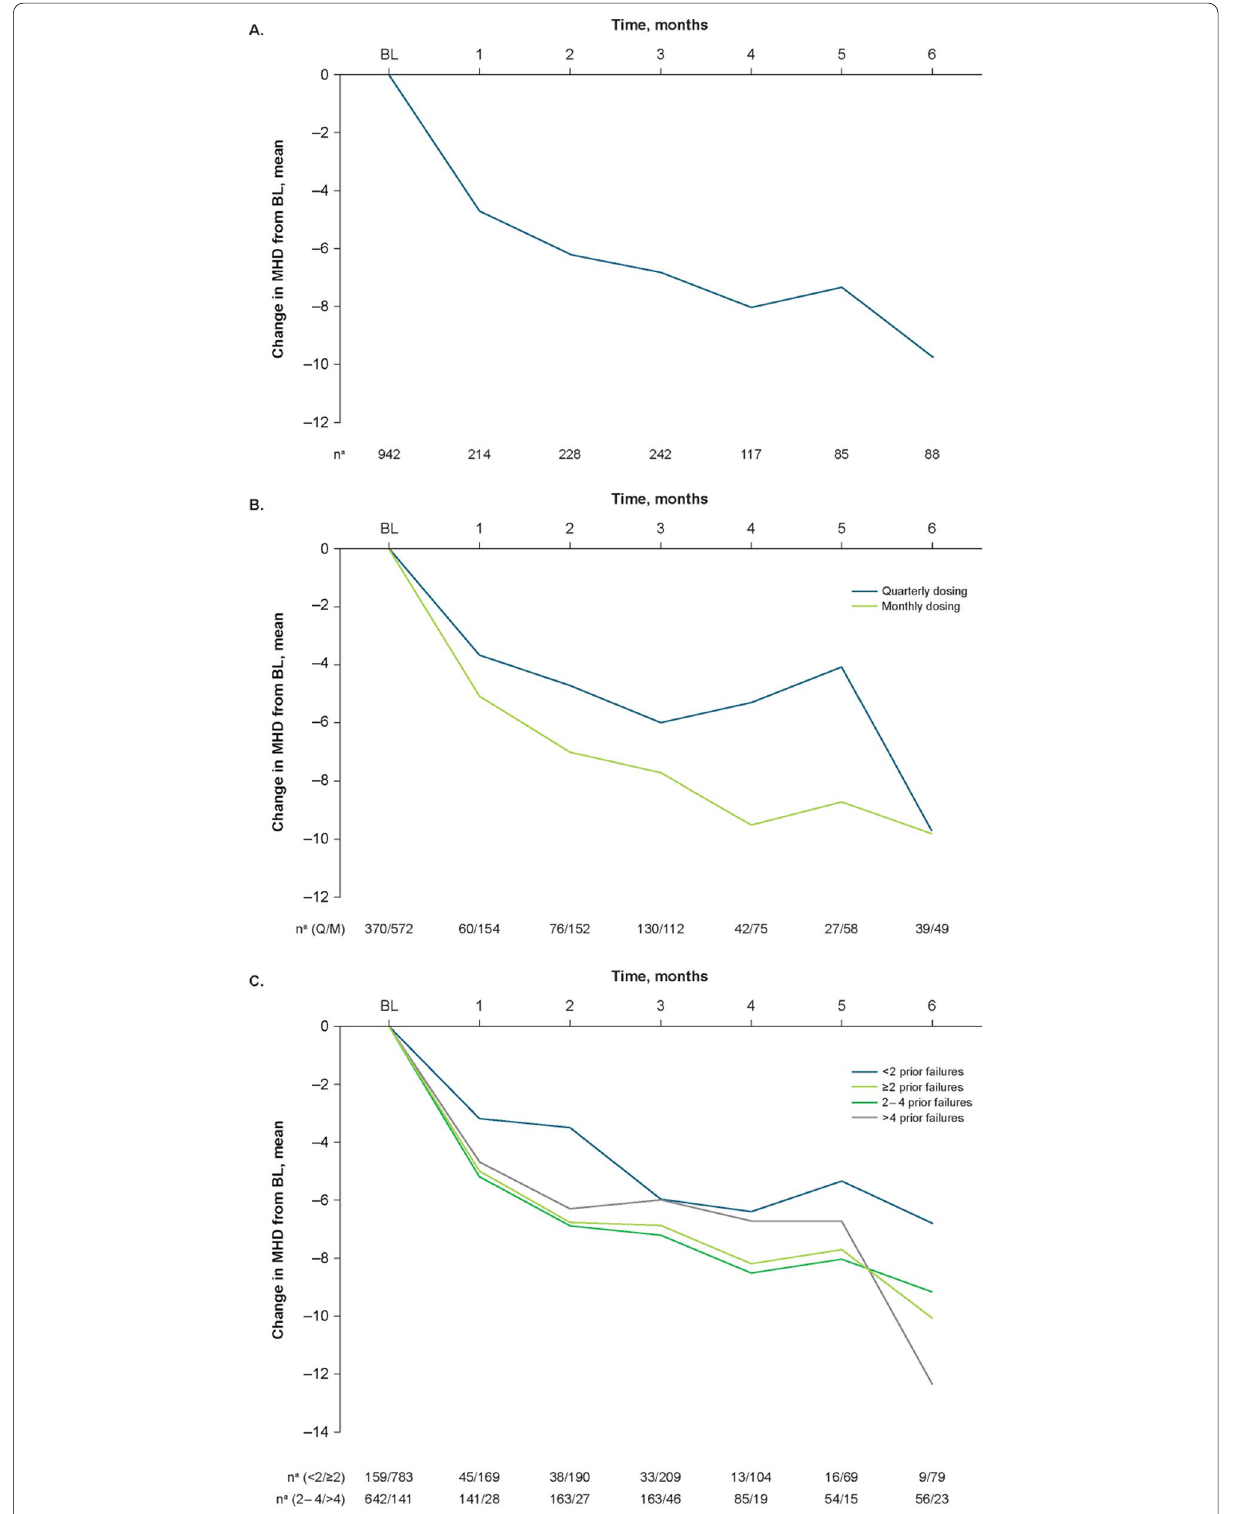
Fig. 4 Effectiveness outcomes by change from baseline in MHD: A ) total population; B ) dosing schedule subgroups; C ) prior treatment failures subgroups. BL, baseline; MHD, monthly headache days; Q, quarterly; M, monthly. a Number of patients with available assessment at each time